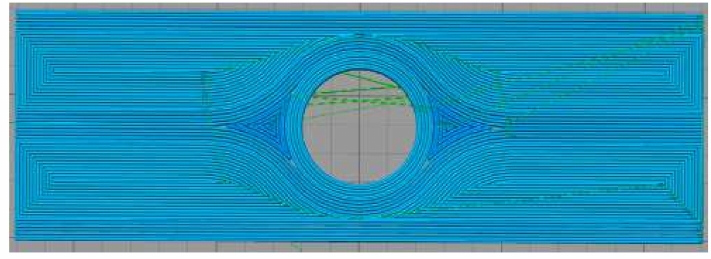
Figure 15. Optimized tool-path.